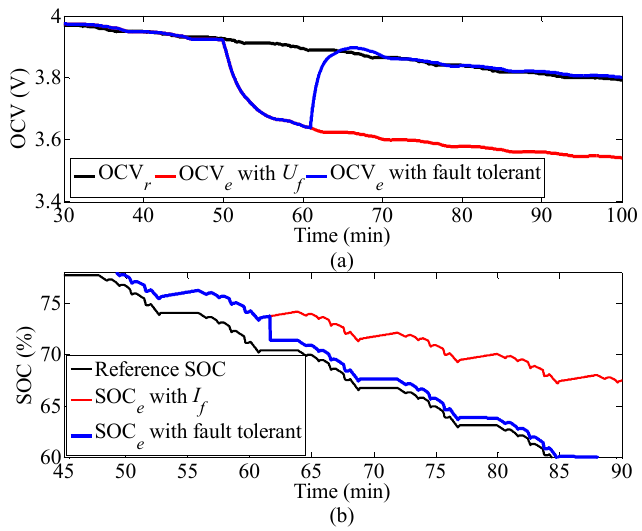
Figure 11. Fault-tolerant control for parameter identification and state estimation: ( a ) OCV; ( b ) SOC. For the current sensor fault, the time when r 3 reaches the threshold J c is selected as t 4 , namely 62.4 min, t 3 is set to be 10 min forward from t 4 , the SOC change between t 3 and t 4 is calculated, and t 1 and t 2 are selected when the sensor does not fail. The selection of t 1 and t 2 is based on the fact that the SOC change during this period is equal to the SOC change during the t 3 and t 4 period. Then, according to Equation (22), the fault value of the current sensor I f is set to 0.245 A, and the error is 0.005 A. Figure 11b shows the fault-tolerant control process of battery state estimation. The battery SOC is automatically corrected to the reference value based on the current fault value and the SOC difference caused by the fault from 62.4